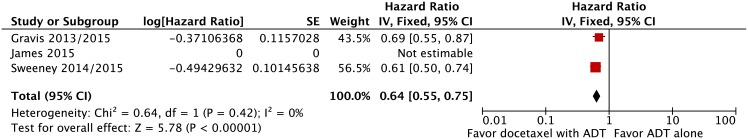
Comparative effect in clinical progression-free survival of ADT with docetaxel versus ADT alone.Abbreviations: ADT, androgen-deprivation therapy; CI, confidence interval.